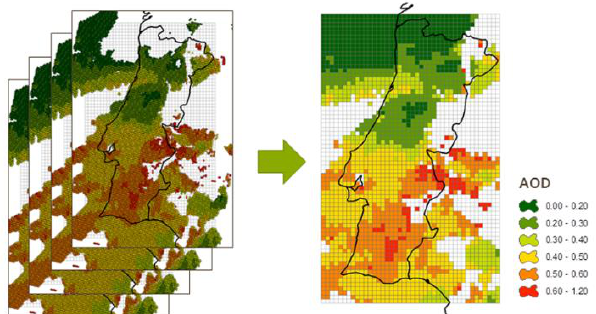
Figure 3. SEVIRI data for 14 May 2011 at 14 UTC: a) original pixel size (3x3 km 2 ) and b) pixel size of the modelling results (9x9 km 2 ).